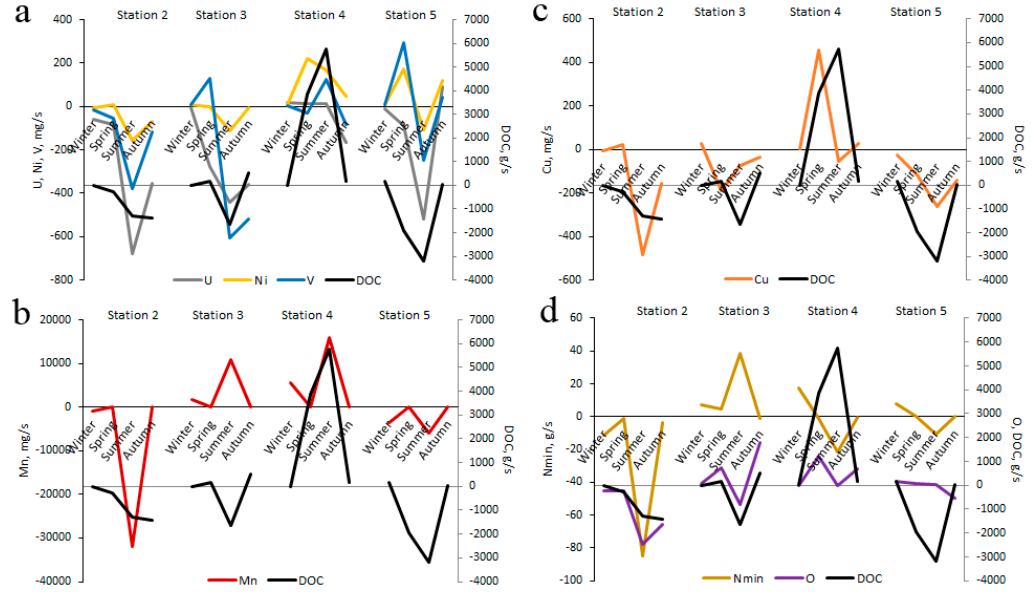
Figure 2. Spatial and temporal variation in removal rates of elements highly correlated with DOC. ( a ) U, Ni, V, ( b ) Mn, ( c ) Cu, ( d ) N min , O.